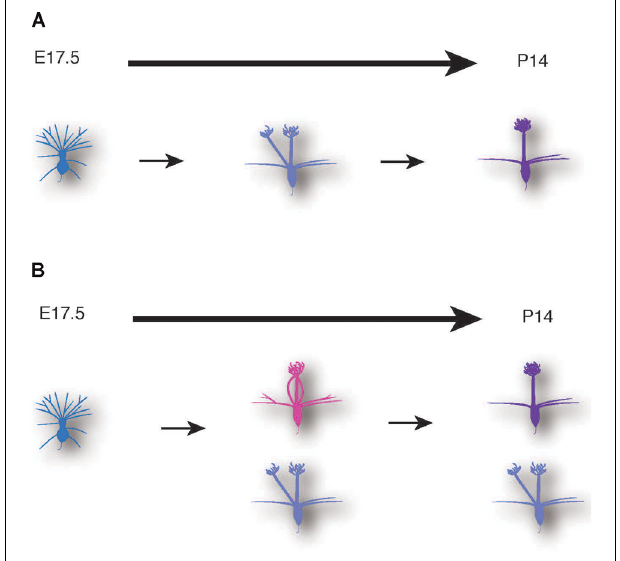
FIGURE 7 | Schematic illustrations of mitral cell development. A conventional model (A) and a novel model based on our data (B) of dendrite remodeling in the developing mouse mitral